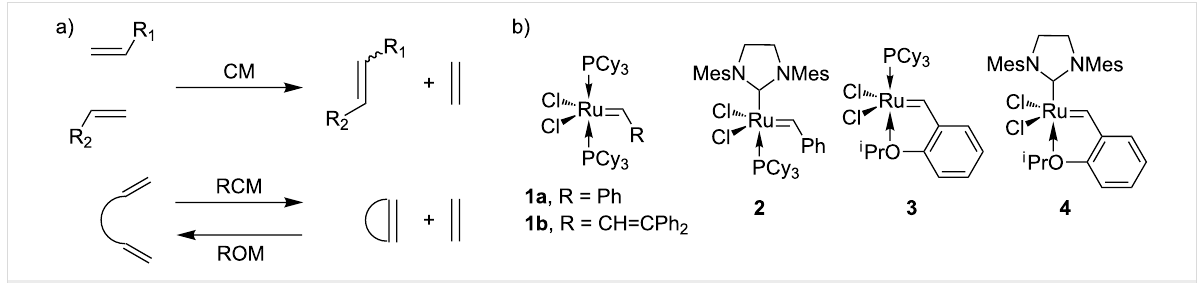
Figure 2: Possible complexes generated through preassociation of allylic alcohol with